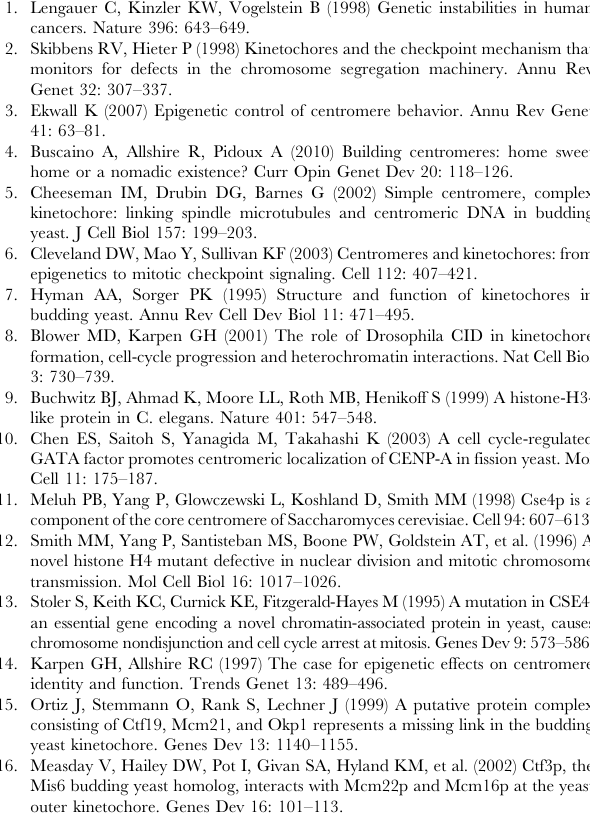
Figure S7 Identification of DNA binding sequences of Scm3p. Predicted DNA binding sequences identified by computational analysis using BindN-RF and MEME software are shown in red and marked with an arrow (amino acids 1-103). Amino acids residues predicted to interact with DNA with high affinity are shown as brown color letters. Symbols, NES = nuclear export signal; HR = Cse4p interacting heptad repeat domain; acidic D/ E region, and BR1 and BR2 are basic regions 1 and 2, respectively.